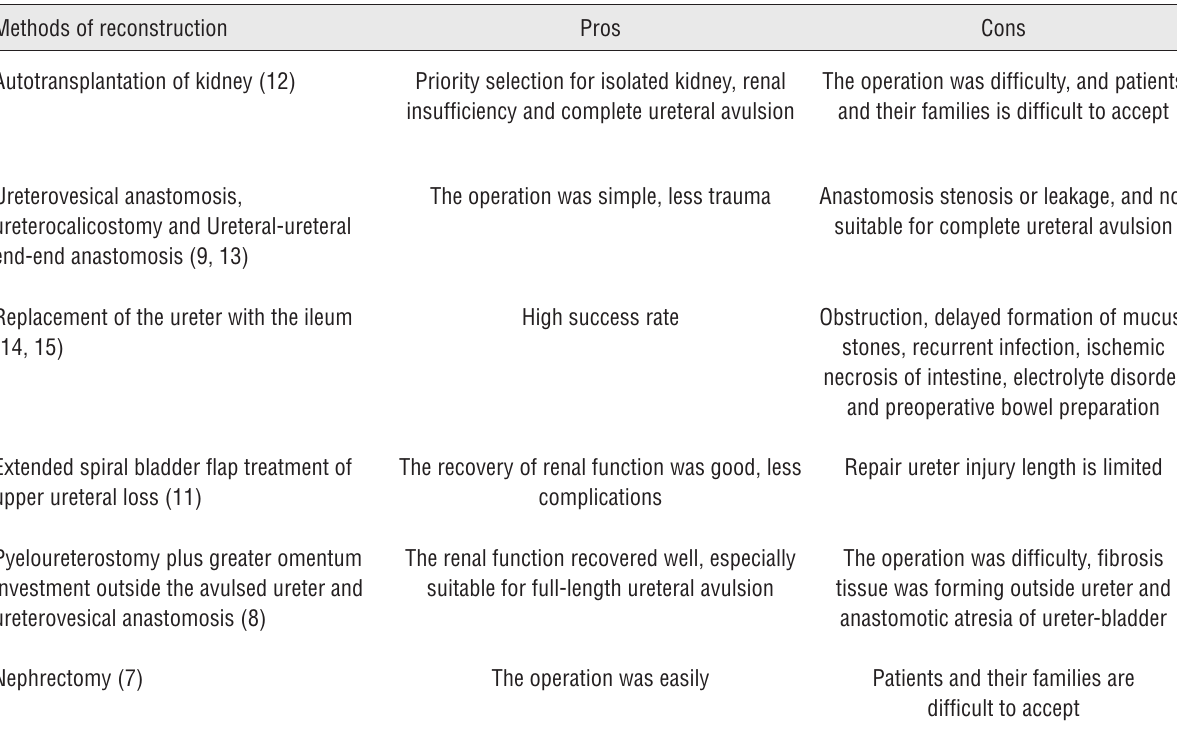
Table 1 - The pros and cons of all treatment options in the management of ureteral avulsion. Methods of reconstruction Pros Cons Autotransplantation of kidney (12) Priority selection for isolated kidney, renal The operation was difficulty, and patients insufficiency and complete ureteral avulsion and their families is difficult to accept